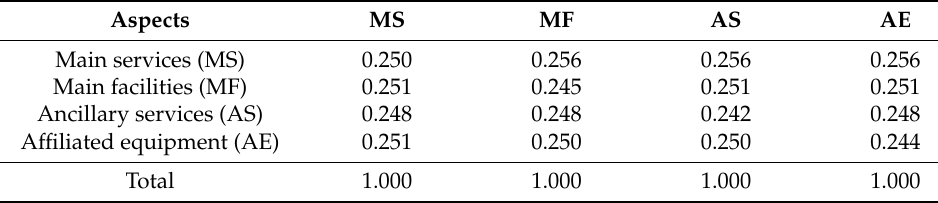
Table 9. The relative weights of